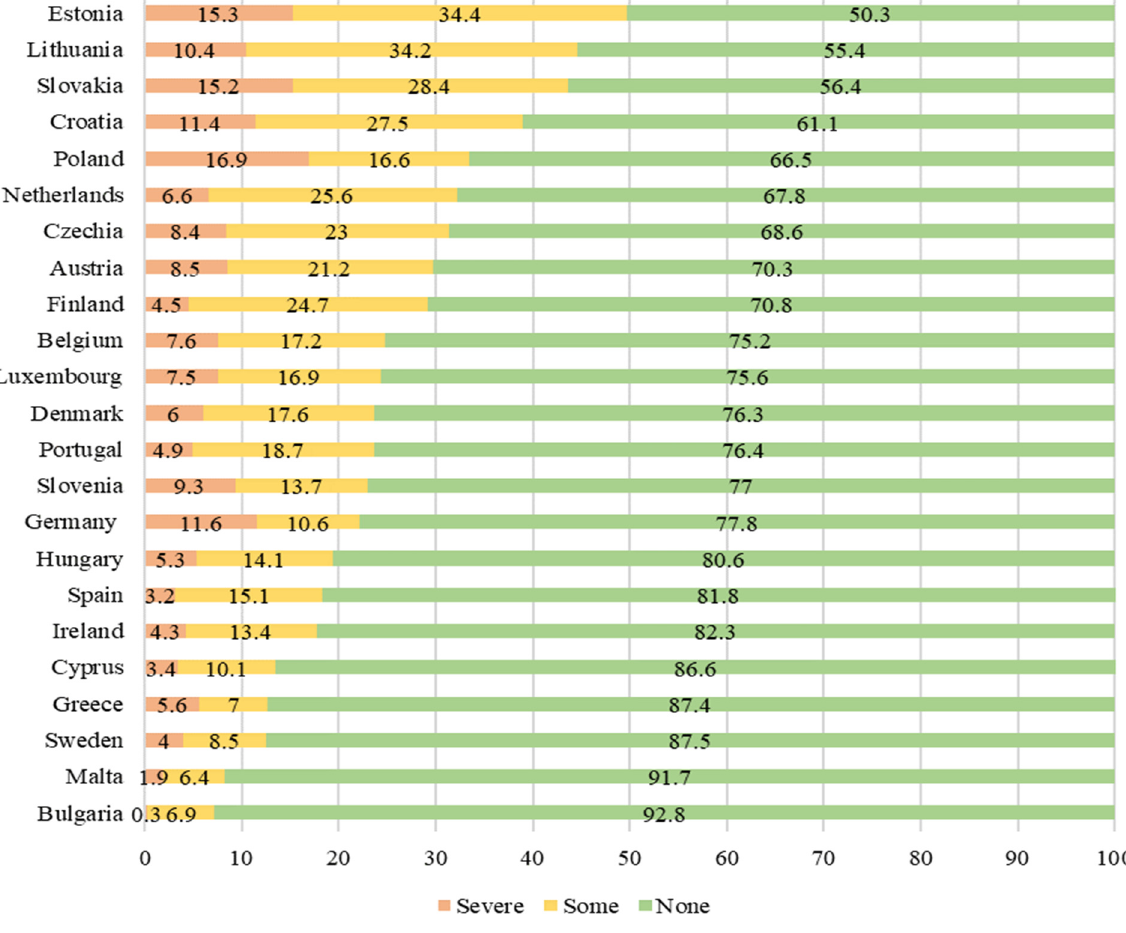
Figure 3. Self-perceived long-standing limitations in usual activities due to health problem, for- eign population, European Union countries (EU28), 2020 (%). Source: Eurostat—last data extracted on 5 December 2021 (online data code: HLTH_SILC_27).